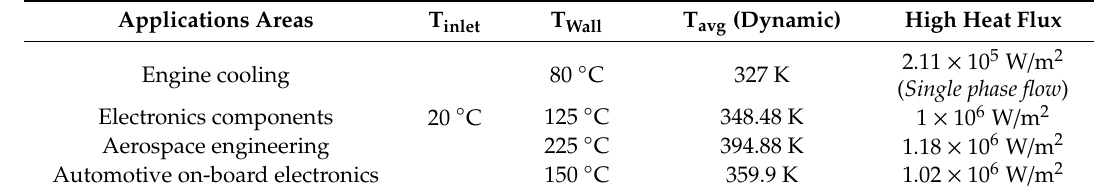
Table 5. Dissipated heat flux values obtained from the